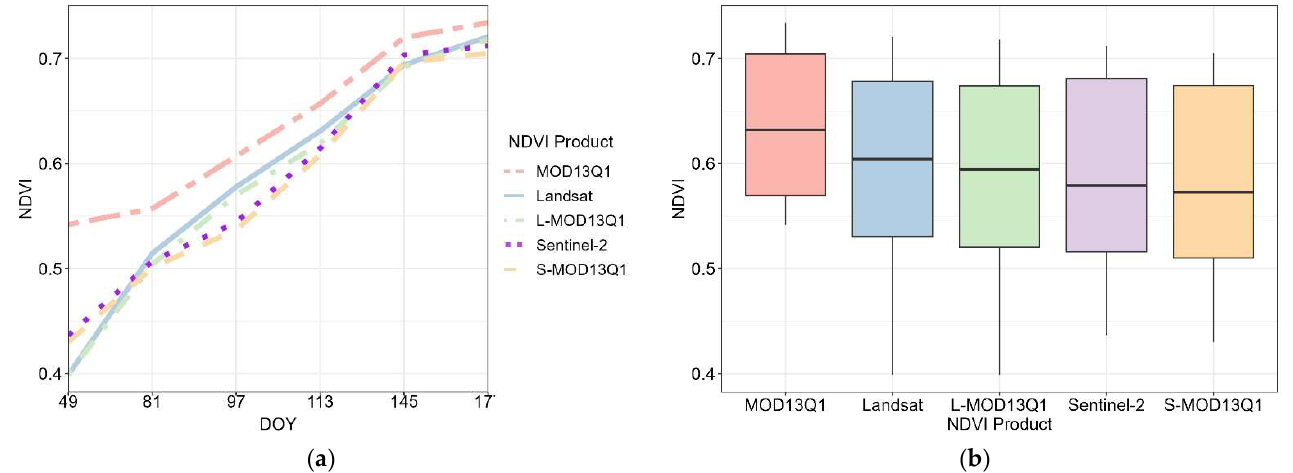
Figure 5. The ( a ) line and ( b ) bar plots show the DOY-based and interquartile-range-based comparison of STARFM-generated NDVI values with their respective high-resolution input (Landsat (L) or Sentinel-2 (S)) and low-resolution input MOD13Q1, respectively. The comparison is based on the mean values extracted for 10,000 random points (whose spatial location is shown in Figure 4f) taken for the entire Bavaria.